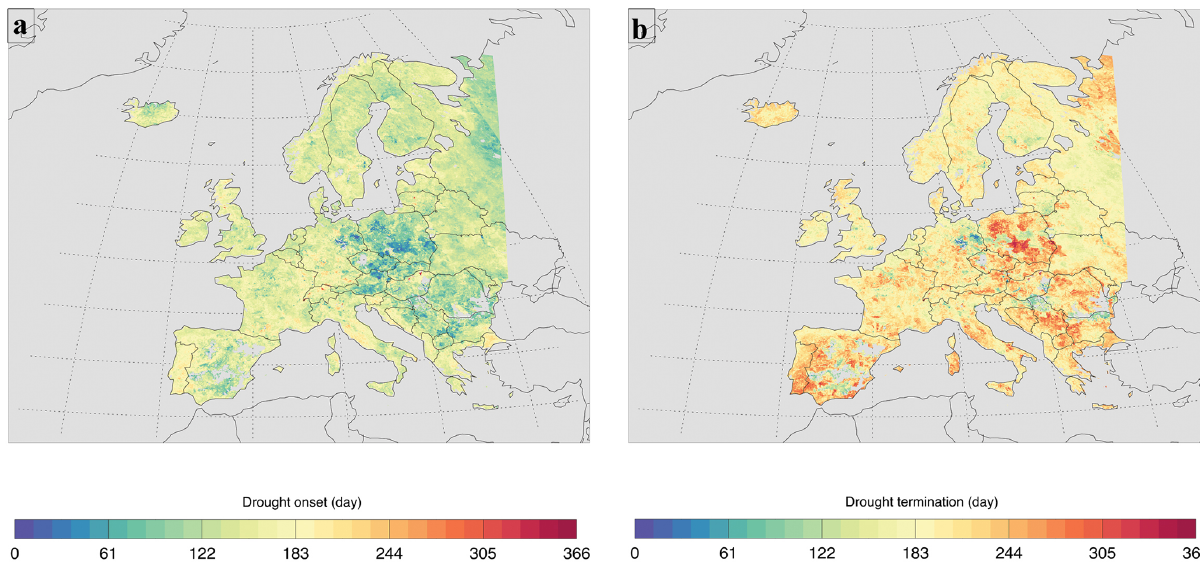
Figure 5. Spatial distribution of the average drought onset (a) and termination (b) of the longest drought per year (in drought years) derived from drought in runoff over the period 1990–2017. Non-drought years are